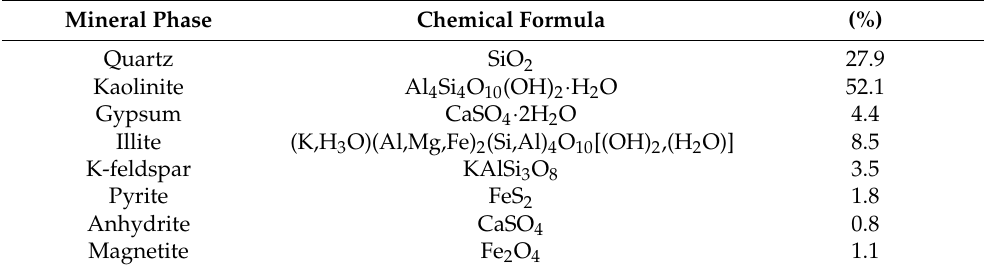
Figure 1. Semi-quantitative mineralogical compositions of the mineral matter in the density fractions obtained from washability studies of coal waste. Table 2. Mineralogical semi-quantitative XRD phases obtained for the ash component of bulk coal discards samples (feed).